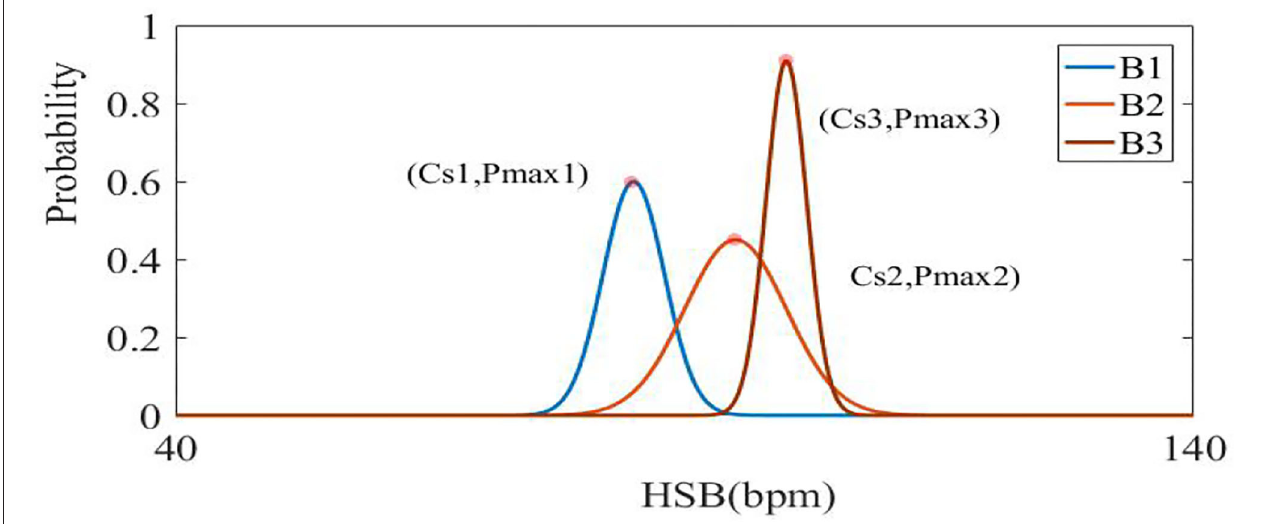
FIGURE 10 | The visualization of B1, B2, and B3 curves represents each update process of statistical probability distribution (from distribution B1–B2, B2–B3). The horizontal axis represents the division of the sub-partition, and the ordinate represents the probability value in a certain interval.